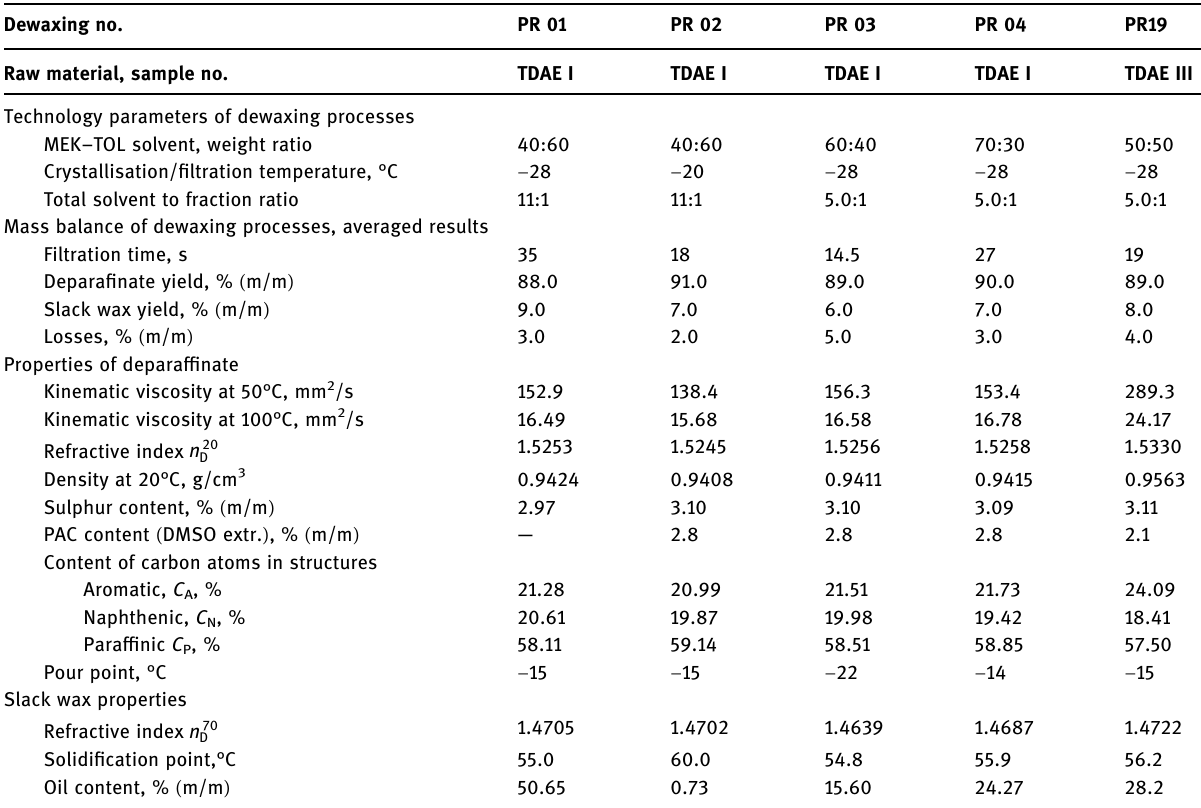
Table 4: Technology parameters, mass balance and properties of the obtained depara ffi nates and slack waxes, in MET - TOL dewaxing processes of TDAE I and TDAE III raw material samples Dewaxing no.